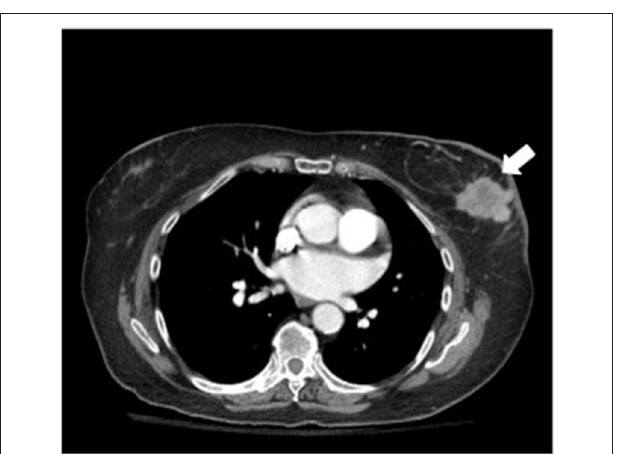
FIGURE 3 | Chest CT showed a 4-cm left-breast mass with central necrosis.